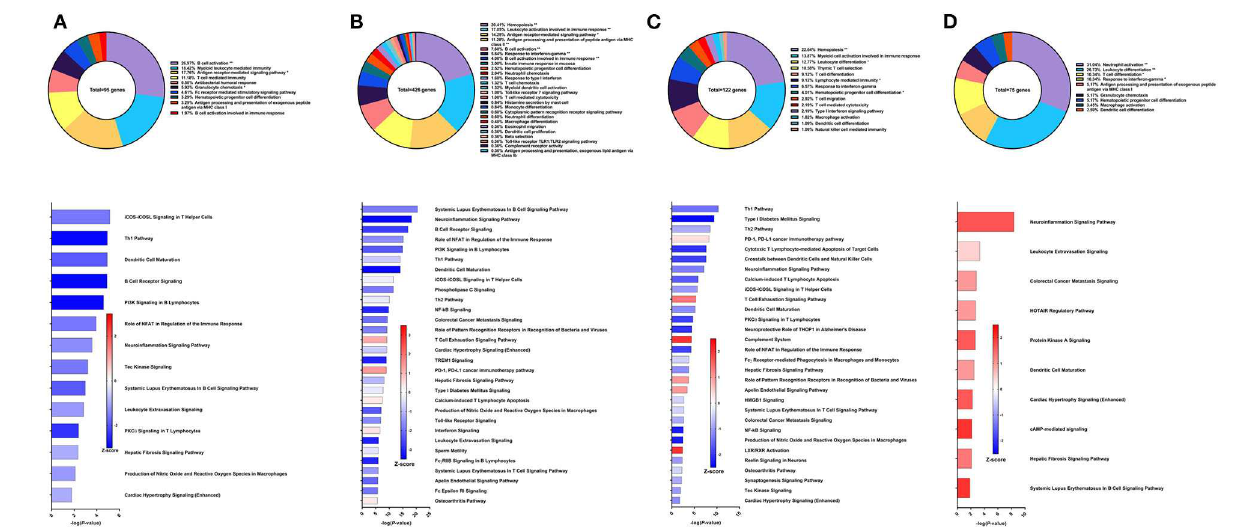
FIGURE 7 | RNA-Seq analysis of rSm-p80 + GLA-AF, a recombinant protein vaccine strategy. (A) PBMCs after vaccination (Top) Gene ontology enrichment analysis represented as a pie graph of percentages of genes per group out of a total number of differentially expressed genes. “**” and “*” indicates P < 0.05 and P < 0.01, respectively. (Bottom) Canonical pathway analysis generated using IPA. Bars are plotted based on the – log10( P -value) and colored based on predicted activation (red) and deactivation/inhibition (blue) according to the Z-score, a composite assessment based on the degree of overlap between directional expression of genes from the observed data and the Qiagen-curated public database. The top 30 pathways are shown based on the lowest P -values. (B) PBMCs after challenge (Top) Gene ontology enrichment analysis. (Bottom) Canonical pathway analysis generated using IPA. (C) Spleen cells (Top) Gene ontology enrichment analysis. (Bottom) Canonical pathway analysis generated using IPA. (D) Mesenteric lymph node cells (Top) Gene ontology enrichment analysis. (Bottom) Canonical pathway analysis generated using